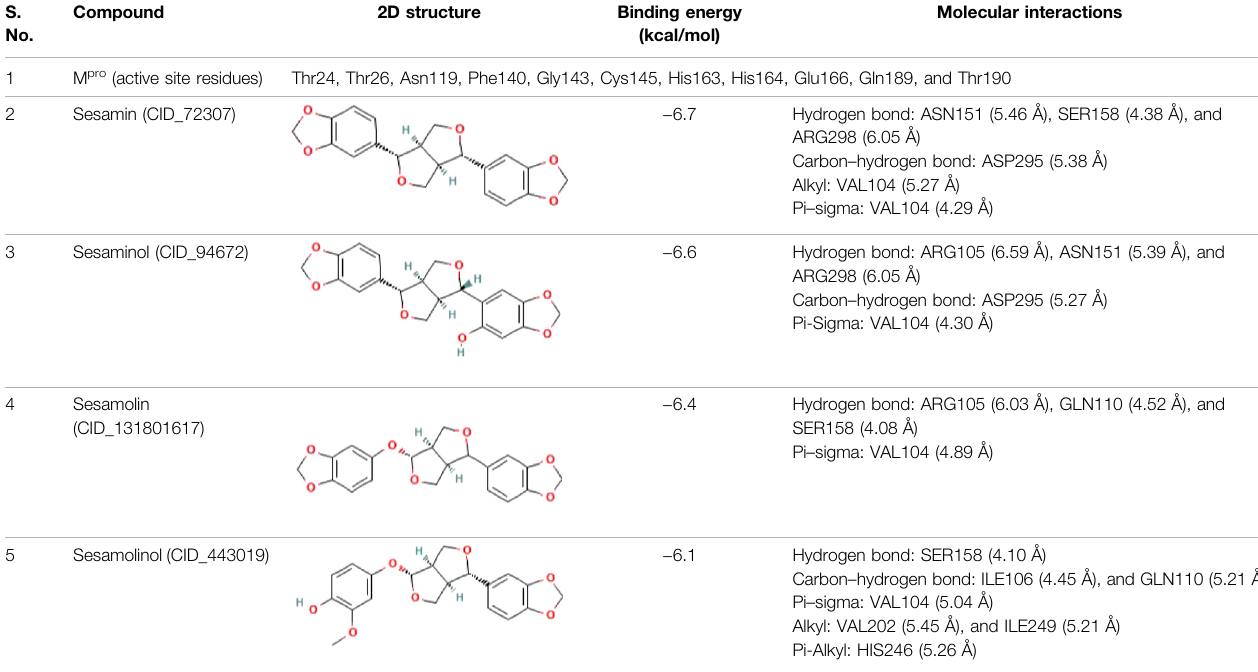
TABLE 1 | List of top four natural compounds shortlisted based on binding energy score as a result of virtual screening. S. Compound 2D structure Binding energy No.